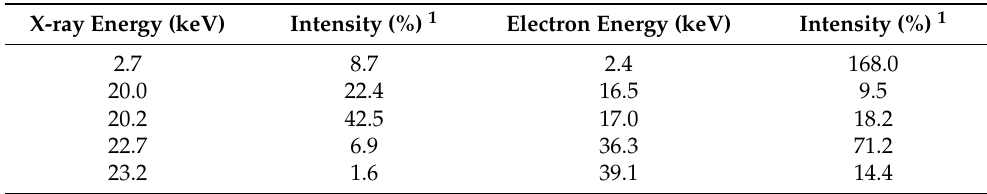
Table 2. Energies of the X-rays and electrons emitted by 103 Pd and their intensity. Only intensities >1% are included